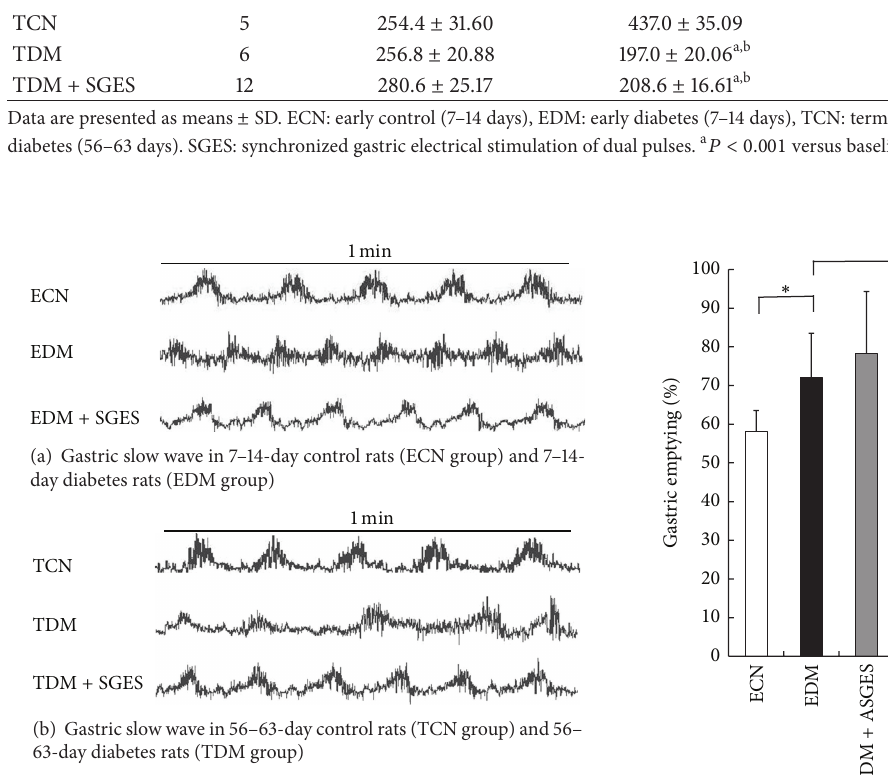
Figure 1: Gastric slow waves in ECN, EDM, TCN, and TDM. The impairedslowwavesofTDMcanbeobservedfromaboverecording. While the rhythm in EDM was normal, the frequency of gastric slow waves increased; SGES normalized the gastric slow waves in EDM and TDM. Note: ECN: early control (7–14 days), EDM: early diabetes (7–14 days), TCN: terminal control (56–63 days), and TDM: terminal diabetes (56–63 days). SGES: synchronized gastric electrical stimulation of dual pulses.